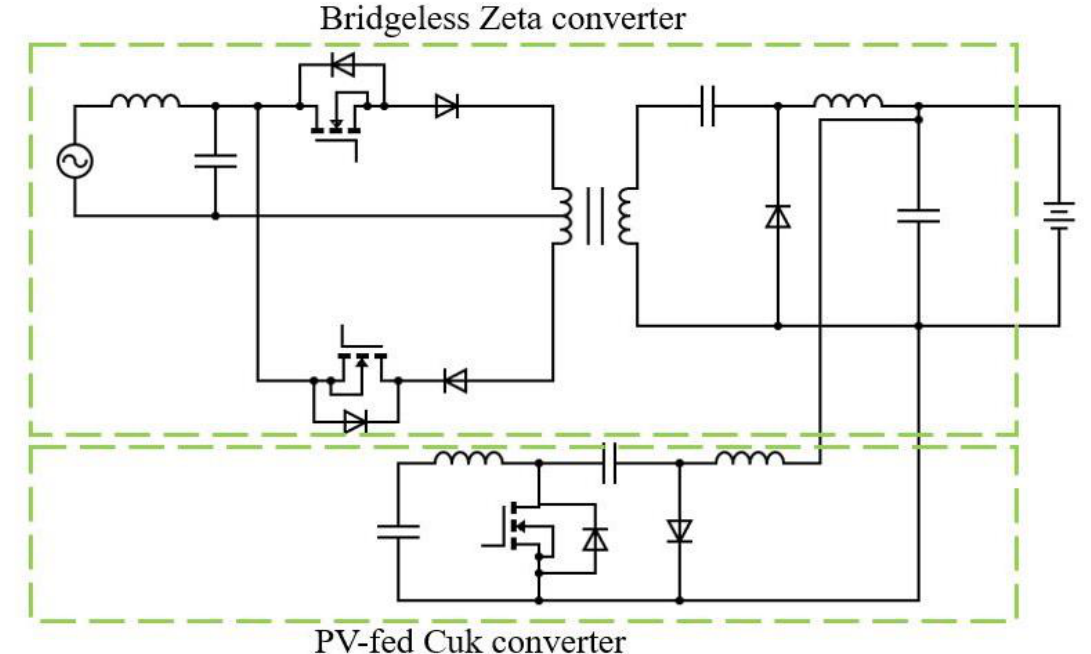
Figure 9. Bridgeless isolated Zeta converter with PV-fed Cuk converter [19].